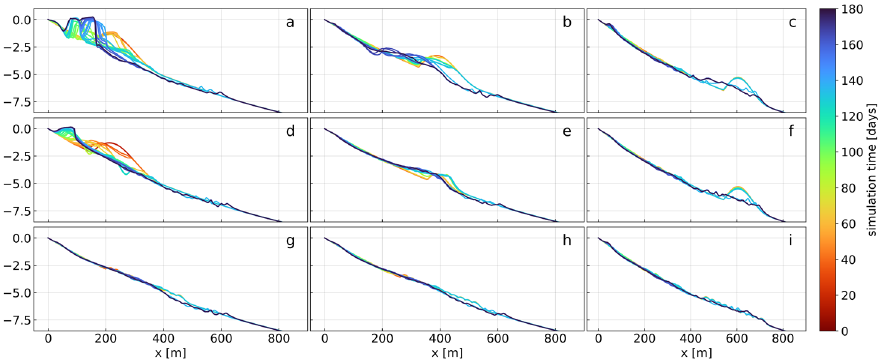
Figure 15. Central profile evolution for SP, where color indicates elapsed simulation time. ( a – c ) LB at 3 m, 5 m, and 7 m depths, respectively. ( d – f ) UB at 3 m, 5 m, and 7 m depths, respectively. ( g – i ) DM at 3 m, 5 m, and 7 m depths, respectively.